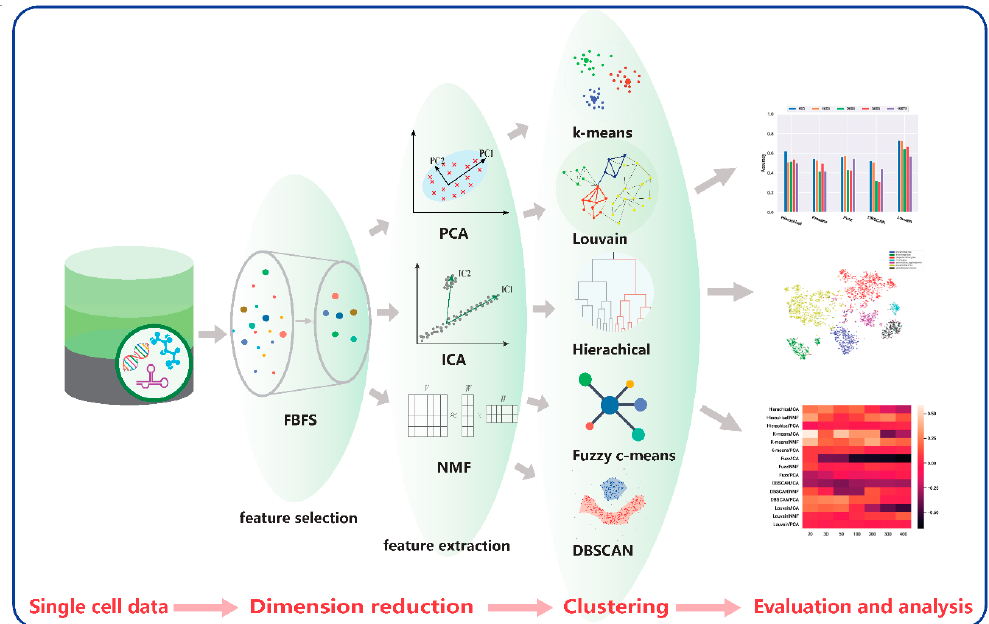
Figure 13. Comparative framework.